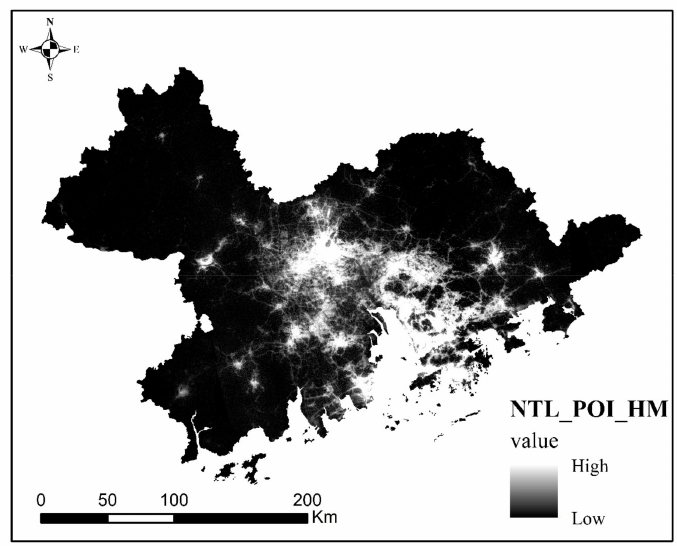
Figure 12. NTL, POI and heat map image fused by wavelet transform.